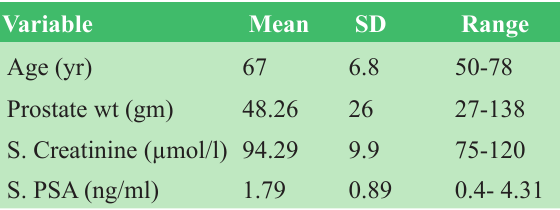
Table 1. Patients’ characteristics and laboratory